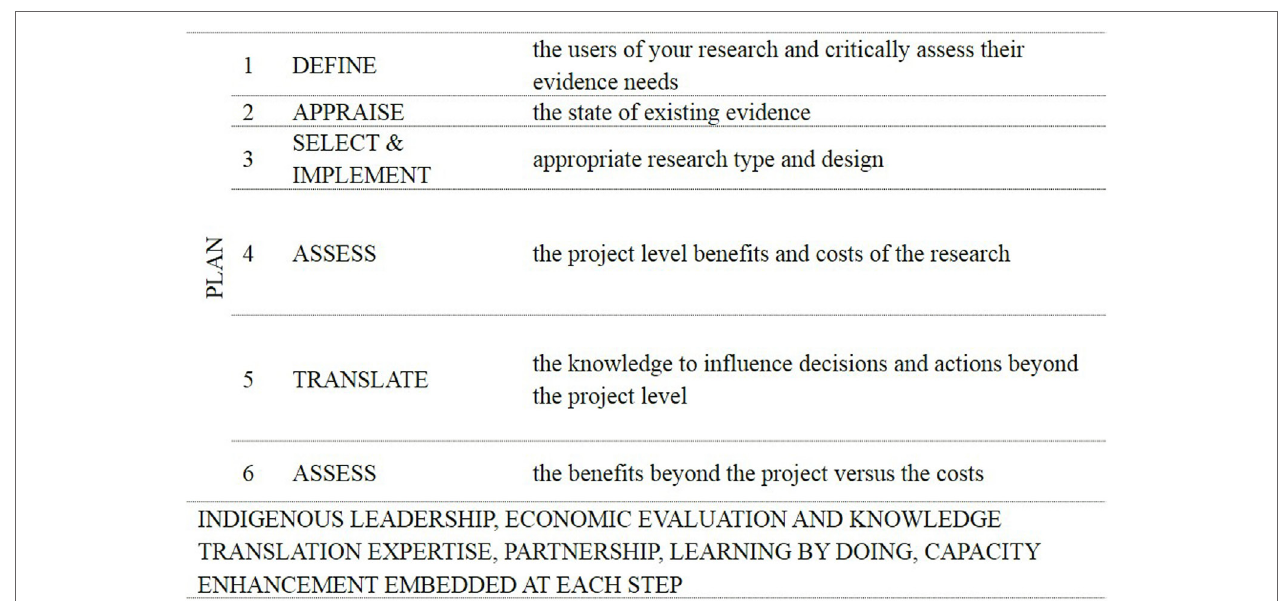
FigUre 2 | Overview of the research for impact tool